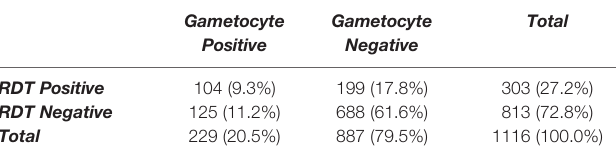
Data are represented as number of samples in each group and percentage of total cohort (in parentheses). Individuals who were RDT positive were more likely to be gametocyte positive, Relative Risk=2.23, P<0.0001, Fisher ’ s exact test.